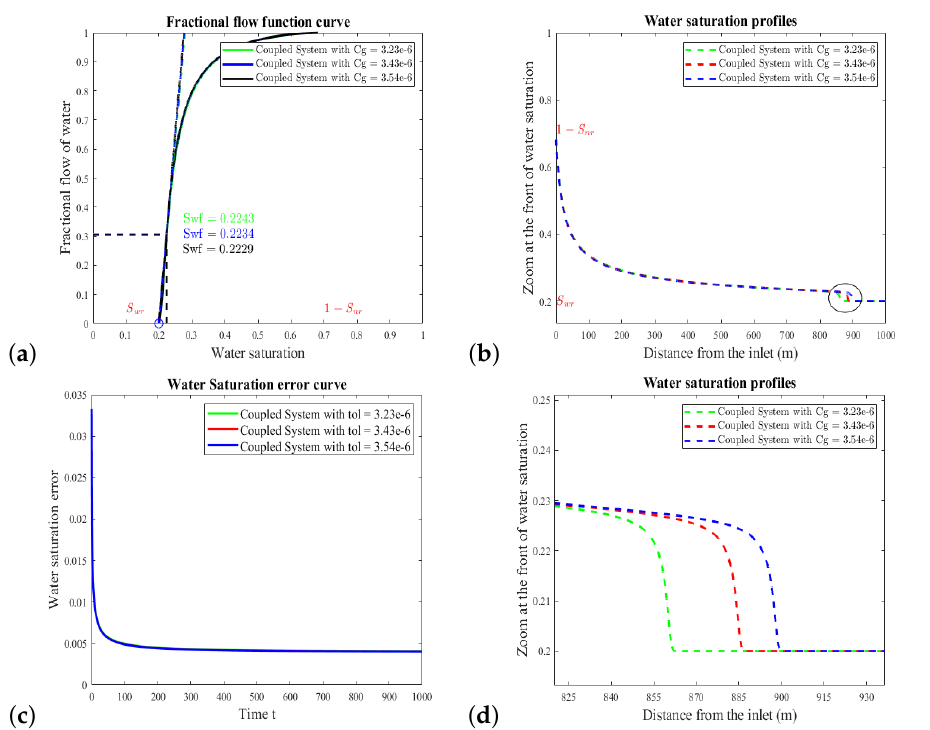
Figure 7. One-dimensional linear water fractional flow and water saturation, and the zoom on the front of water saturation profiles after 1000